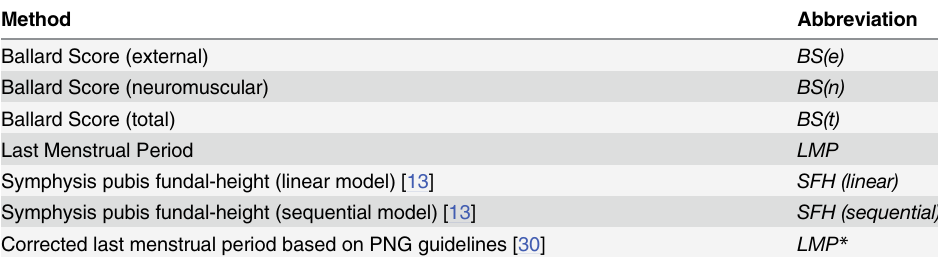
Table 1. Abbreviations for Clinical Measures Used the Text. Method Abbreviation Ballard Score (external) BS(e) Ballard Score (neuromuscular) BS(n) Ballard Score (total) BS(t) Last Menstrual Period LMP Symphysis pubis fundal-height (linear model) [13] SFH (linear) Symphysis pubis fundal-height (sequential model) [13] SFH (sequential) Corrected last menstrual period based on PNG guidelines [30] LMP * Note: LMP * is the corrected last menstrual period based on PNG